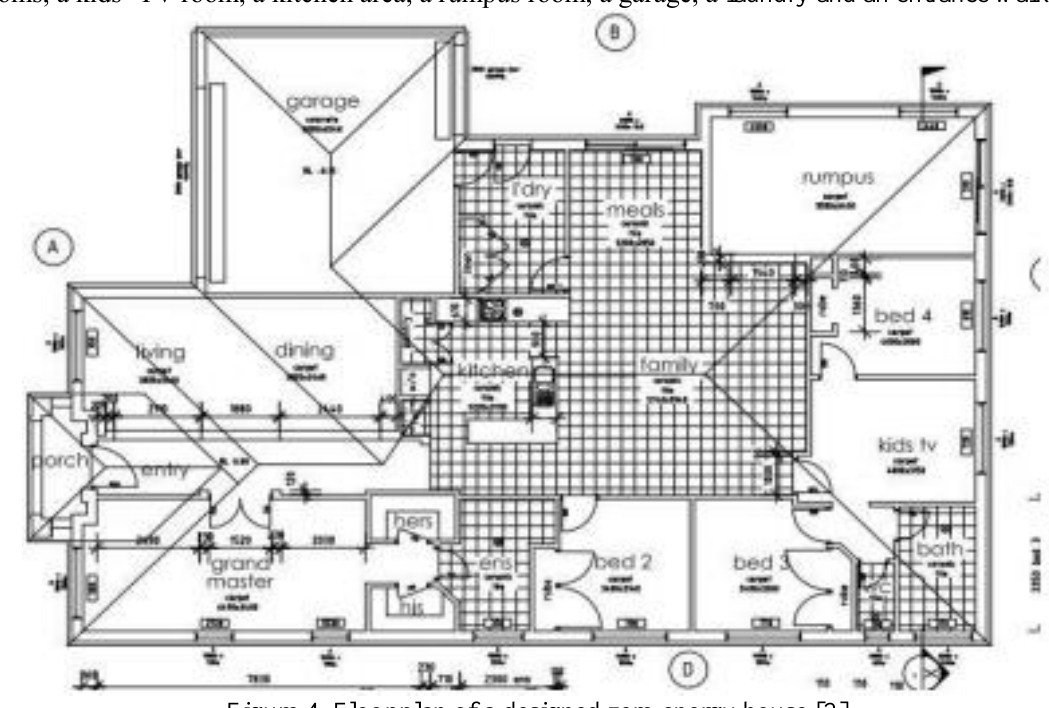
Figure 4. Floor plan of a designed zero energy house [2]